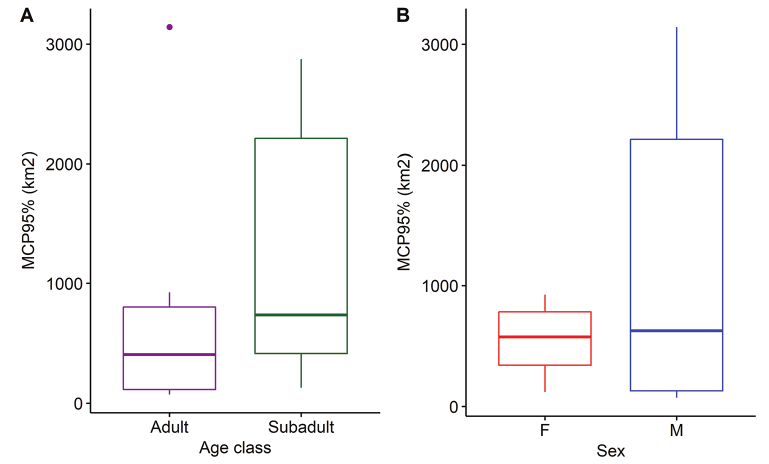
Figure 2. Brown bear home range (MCP95%) size by age class ( A ) and sex ( B ) in Eastern Romanian Carpathians and Subcarpathians (box = interquartile range, horizontal line = median, whiskers = 1.5 × interquartile range, points = outliers).